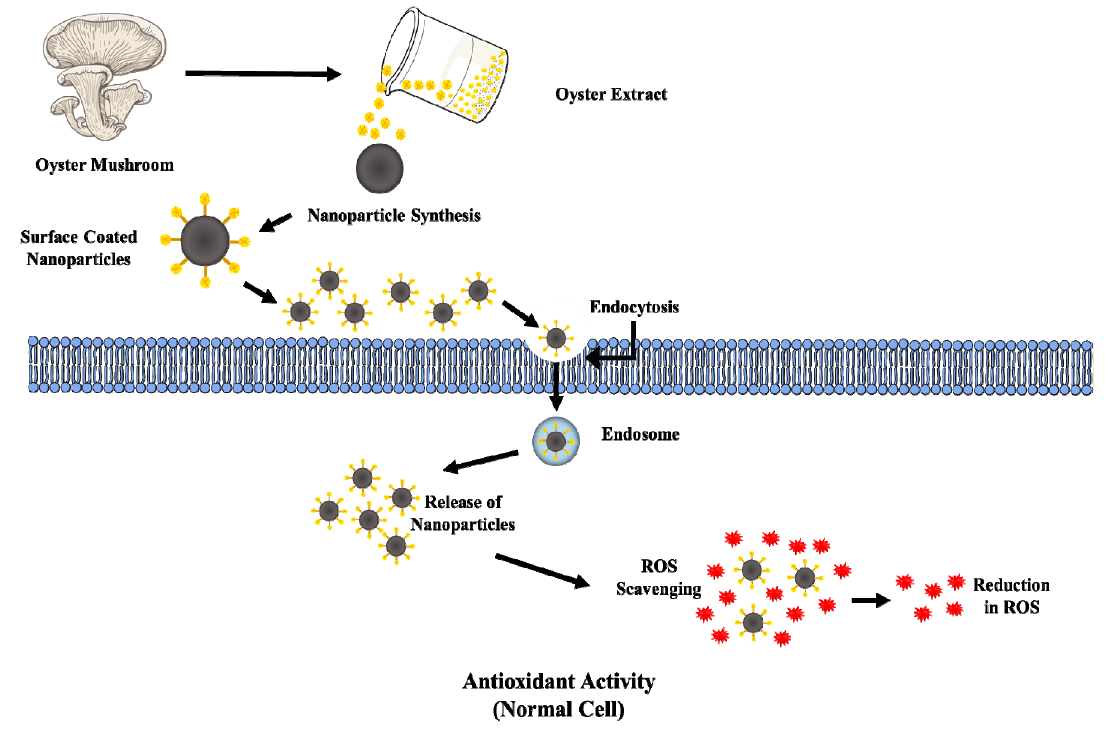
Figure 4. Schematic diagram of the antioxidant mechanism.